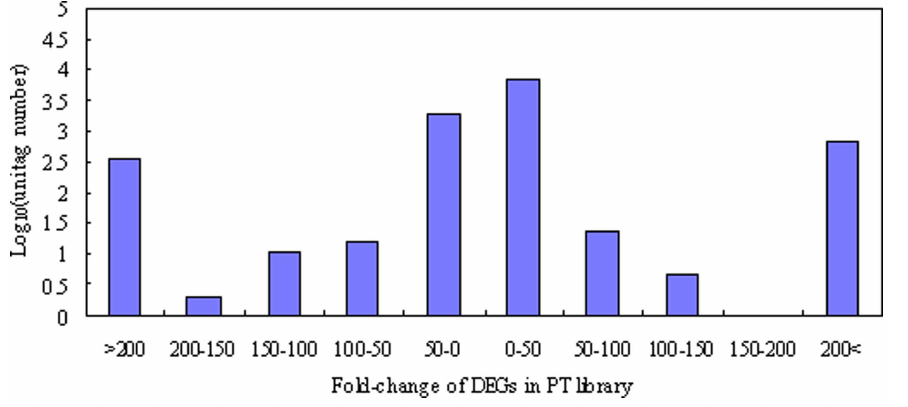
Figure 4. Differentially expressed genes in phenol tissue library. The ‘‘X’’ axis represents fold-change of DEGs in the PT library. The ‘‘y’’ axis represents the number of unique tags (log 10).